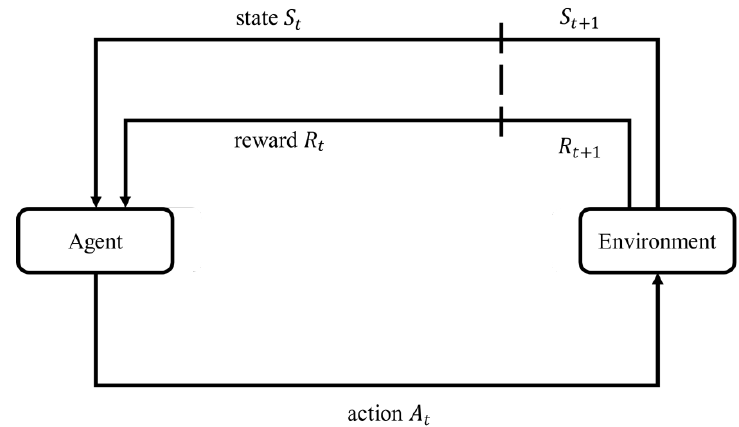
Figure 1. The interaction progress between agents and environments in RL.